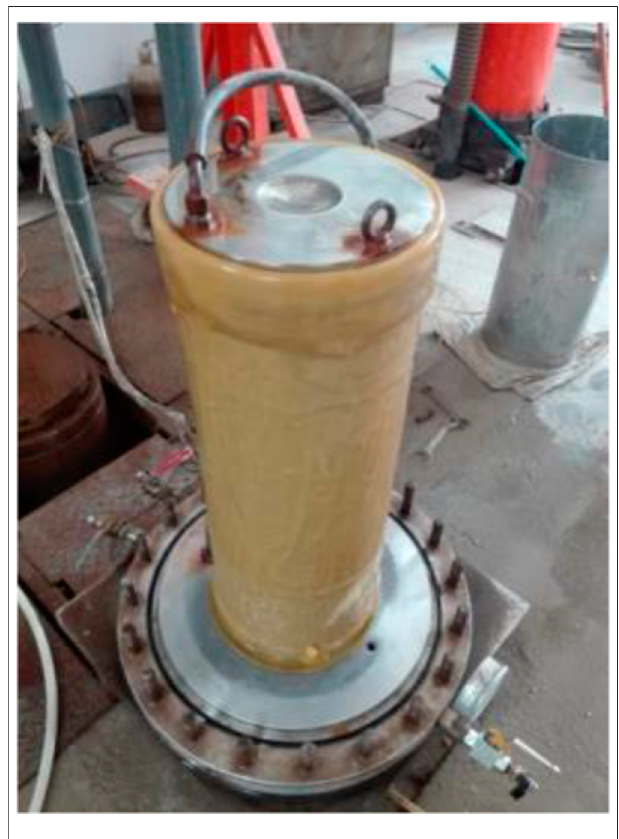
FIGURE 2 | Gradation curve of sericite quartz schist. FIGURE 3 | Finished